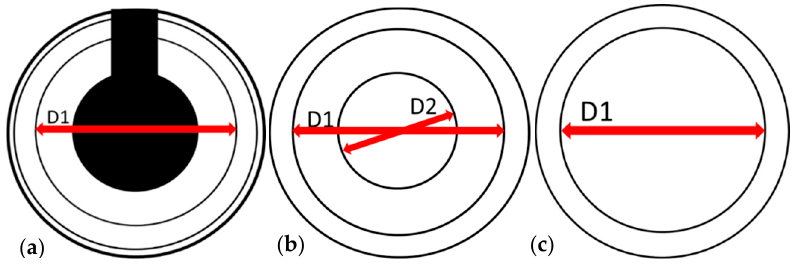
Figure 4. Light microscopic measurement of the diameters at the matrices. ( a ) Novaloc—yellow; ( b ) Locator—pink; ( c ) Locator—orange.